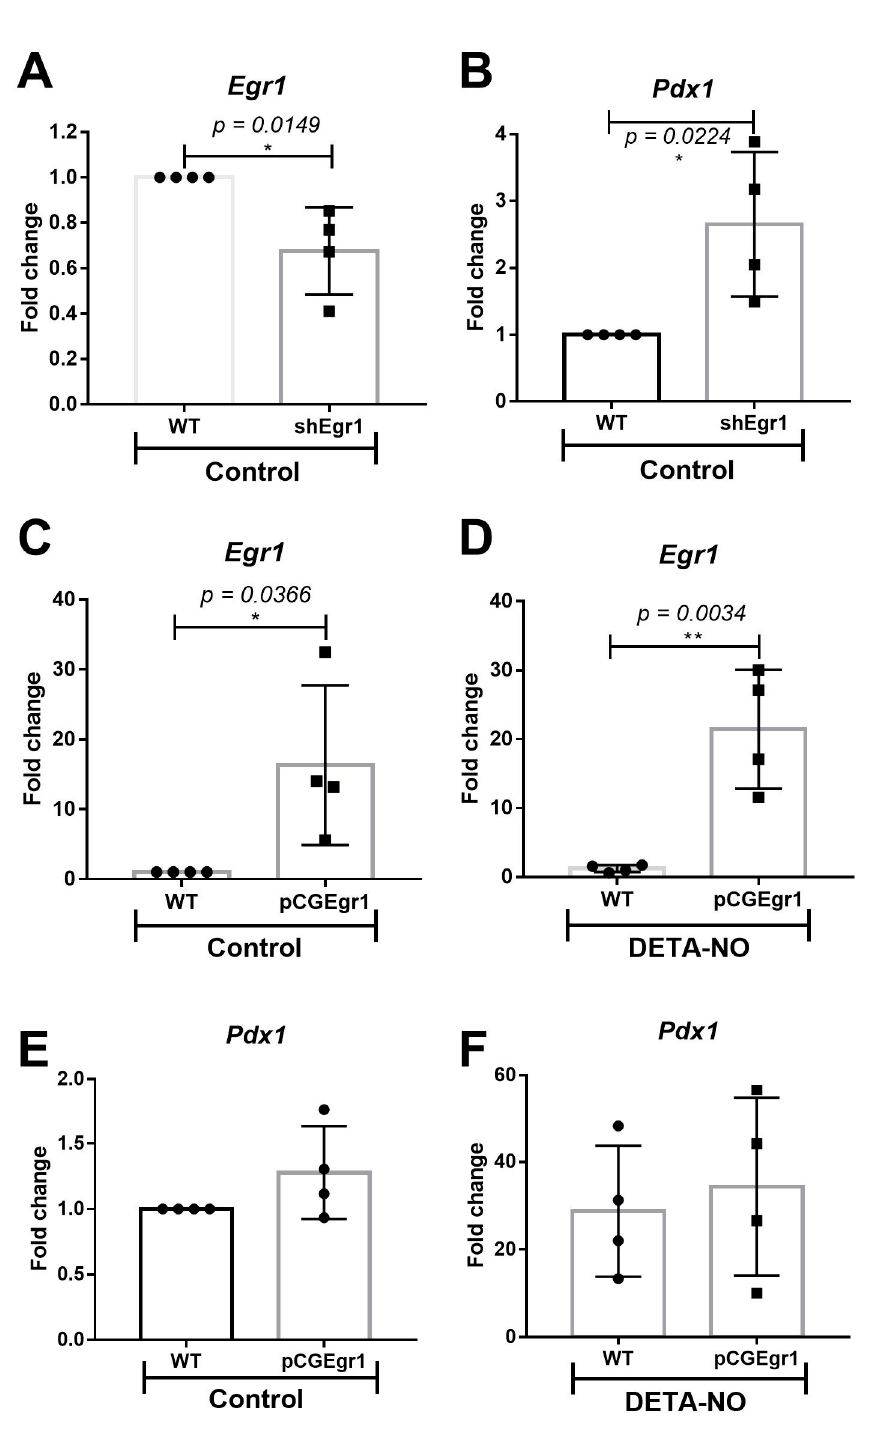
Figure 2. Role of EGR-1 in Pdx1 expression. ( A , B ) EGR-1 loss of function assays. mESCs were transfected with a shEgr1 pool and selected with puromycin. ( A ) Egr-1 and ( B ) Pdx1 expression were analyzed by real time-PCR in wild-type (WT) cells and silenced cells (shEgr1) cultured in control condition. ( C – F ) EGR-1 gain of function assays. mESCs were transfected temporally with the vector pCG-Egr1-HA. ( C , E ) EGR-1 and ( D , F ) Pdx1 expression were analyzed by real time-PCR in WT and EGR-1-overexpressing cells (pCGEgr1) cultured in control and DETA-NO conditions. Data were normalized to the expression values of β -actin, used as the loading control and analyzed using the ∆∆ Ct algorithm. Bar graphs represent the means ± SD of four independent experiments. Data with * p < 0.05 or ** p < 0.01 were considered statistically